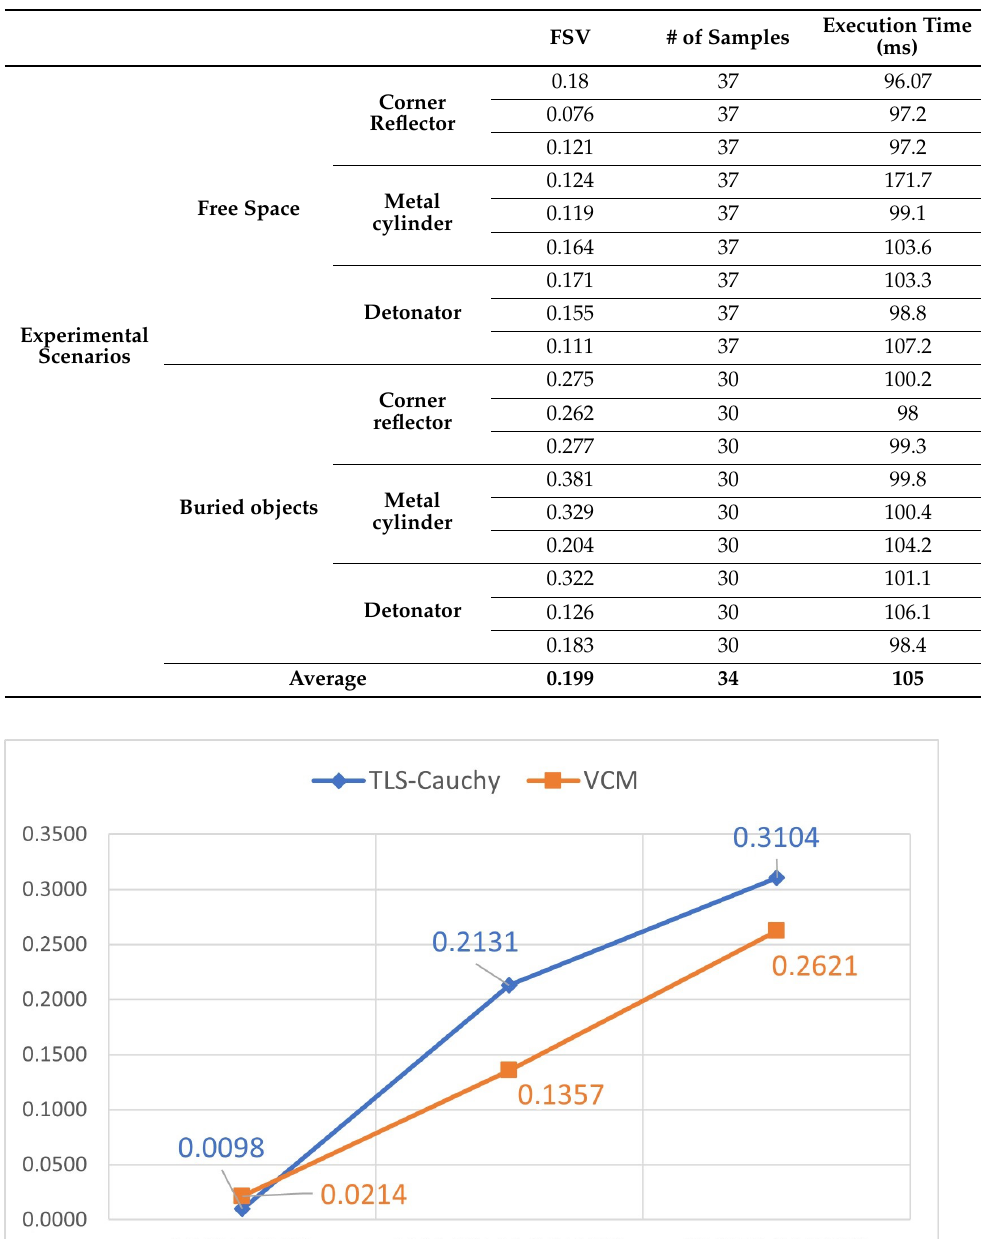
Table 3. Free space and buried objects scenarios’ FSV results for VCM, with execution time and the number of samples used.